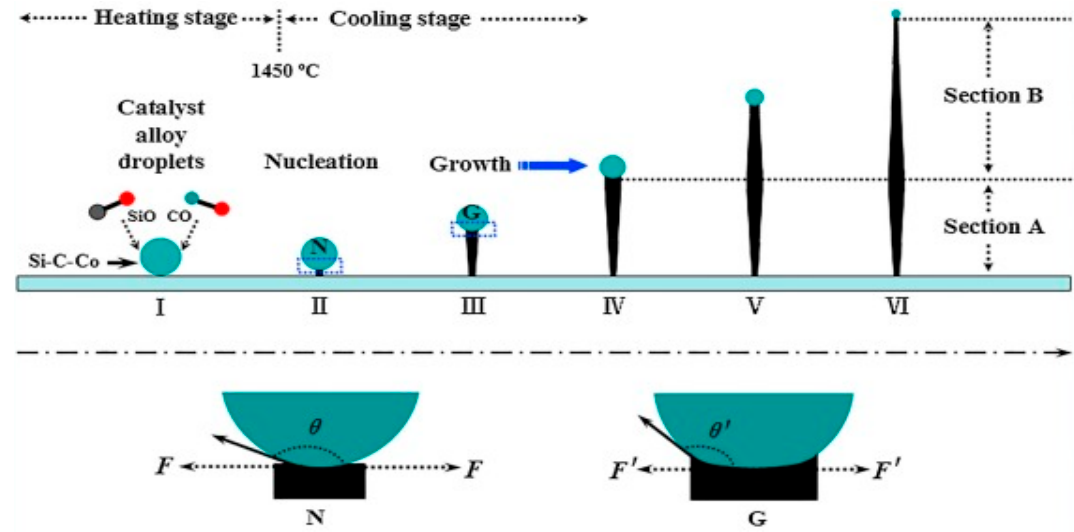
Figure 5. Overall formation mechanism of 1D SiC on the basis of the VLC method [56]. Sun et al. used a high temperature CVD technique to fabricate β -SiC NWs [57]. In this